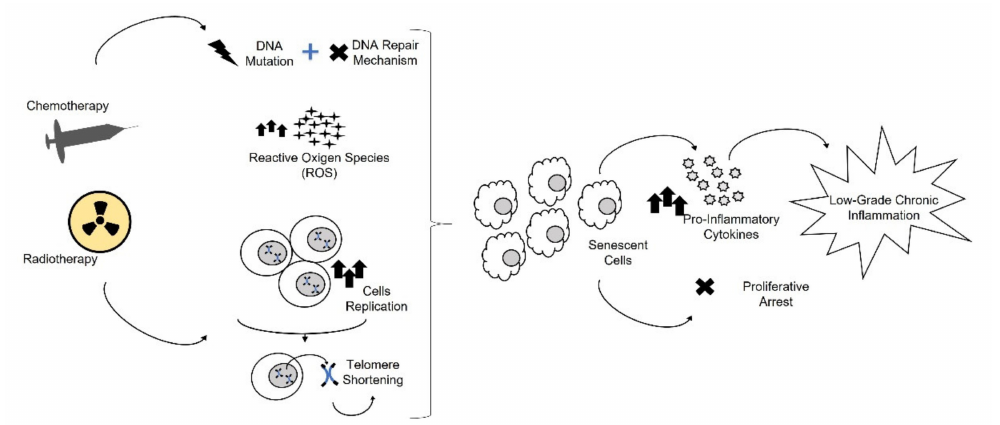
Figure 4. Senescence. Chemotherapy and radiotherapy cause DNA damage, impairment of repair mechanisms, Reactive Oxigen Species (ROS production), and continuous cell replication which is responsible for telomere shortening. All these consequences cause the onset of cellular senescence. Senescent cells are characterized by an increased release of pro-inflammatory cytokines and by the loss capability to grow and replicate, thus contributing to